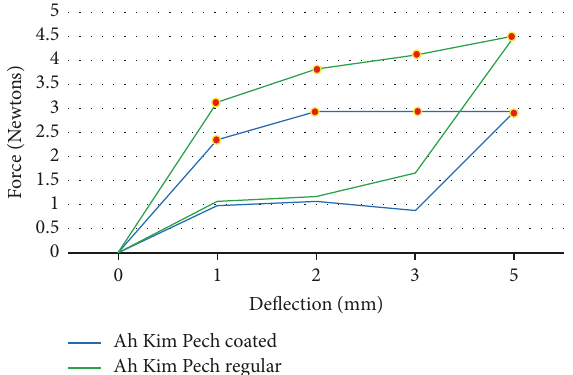
Figure 3: Comparison of the mean force (N) load and unload deflectionbetweenthecoatedandregularAhKimPech0.016 󸀠󸀠 Ni-Ti wires.TherewasastatisticallysignificantdifferenceinthecoatedNi- Ti wires at 1mm ( 𝑝 < 0.001 ), 2 mm ( 𝑝 < 0.001 ), 3mm ( 𝑝 < 0.001 ), and 5 mm ( 𝑝 < 0.001 ) load deflection and for unload deflection at 1mm ( 𝑝 < 0.001 ), 2 mm ( 𝑝 < 0.001 ), and 3 mm ( 𝑝 < 0.001 ).